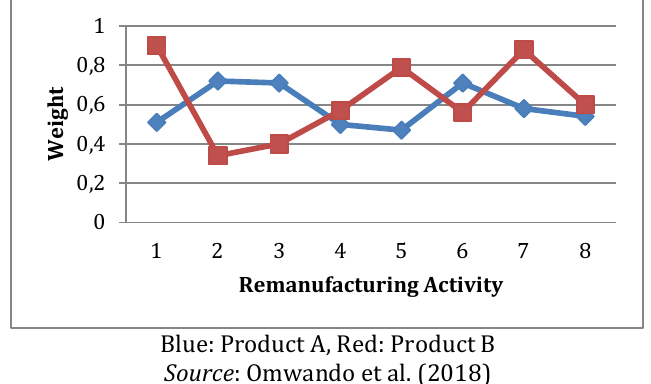
Figure 22: Remanufacturing activities satisfaction weight variation